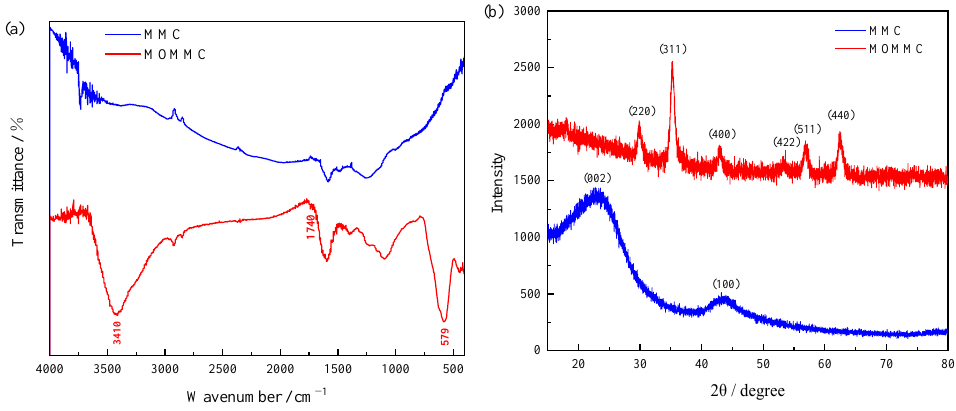
Figure 2. FTIR spectrum ( a ) and XRD patterns ( b ) of MMC and MOMMC.